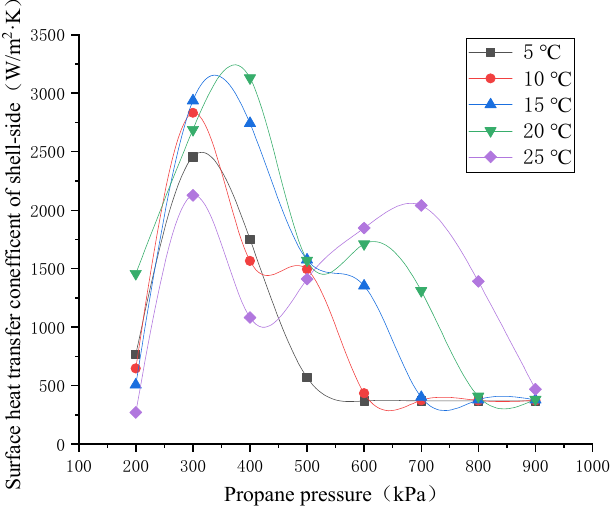
Figure 6. Effect of propane pressure on the surface heat transfer coefficient of the shell side. During the operation of an IFV, the change in seawater temperature will cause a large fluctuation in the propane working pressure, which may lead to a reduction in heat transfer. As can be seen from Figure 6, when the seawater temperature varied from 5 ◦ C to 25 ◦ C, the higher surface heat transfer coefficient was located in the range of 300 kPa to 400 kPa, and keeping the pressure of propane in this range could effectively improve the IFV’s performance. Therefore, in this study, by default, the IFV was operated with the optimal propane pressure at each seawater temperature, and the calculations were based on this. The seasonal influence on seawater temperature was considered by adjusting the seawater outlet temperature and NG outlet temperature. The temperature and flow rate of seawater are the main variables during IFV operation. Therefore, the effect of seawater temperature and mass flow rate on the overall heat transfer coefficient was investigated, and the trend of the overall heat transfer coefficient is shown in Figure 7.